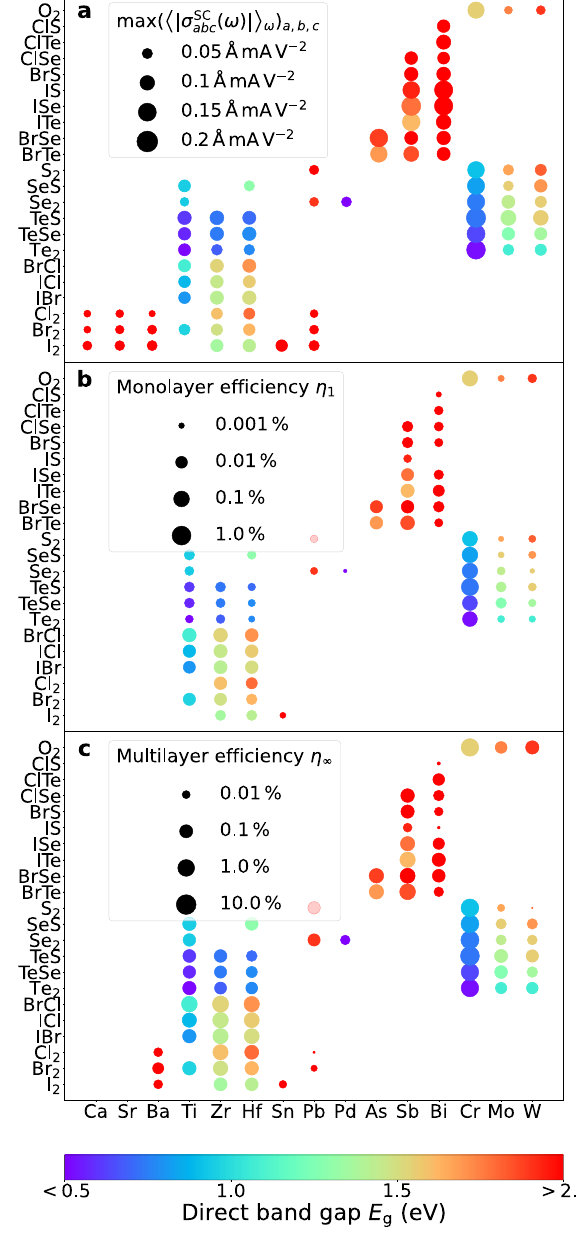
Fig. 8 Ef fi ciency dependence of chemical composition. a Maximum SC tensor element magnitude averaged over frequency. Monolayer b and multilayer c PV ef fi ciencies, for different TMDs of the MXY class. Horizontal and vertical axes show metal (M) and chalchogenide (XY) constituents,